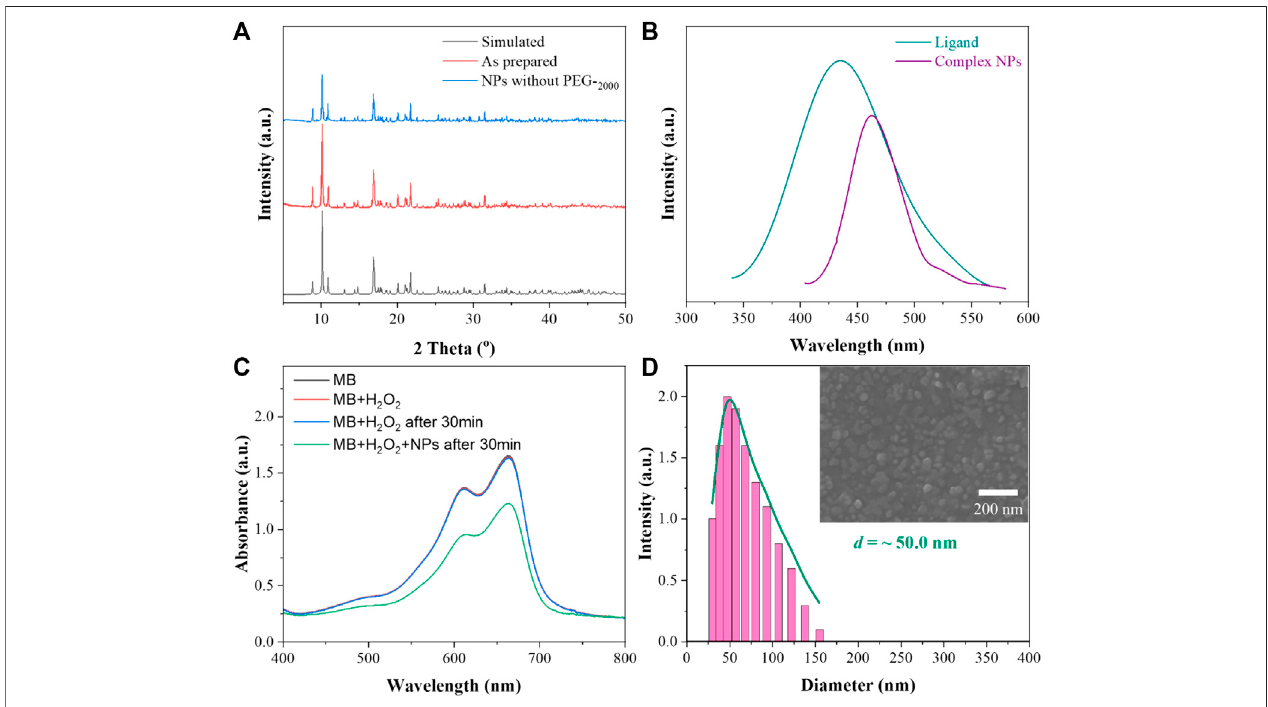
FIGURE1|(A) XRDpatternsofthecomplex; (B) schematicdiagramofthe fl uorescenceemissionspectrumoftheligandandcomplexNPs; (C) MBdegradationin the presence of H 2 O 2 with the complex NPs for the detection of generation of hydroxyl; (D) DLS and SEM images of the complex